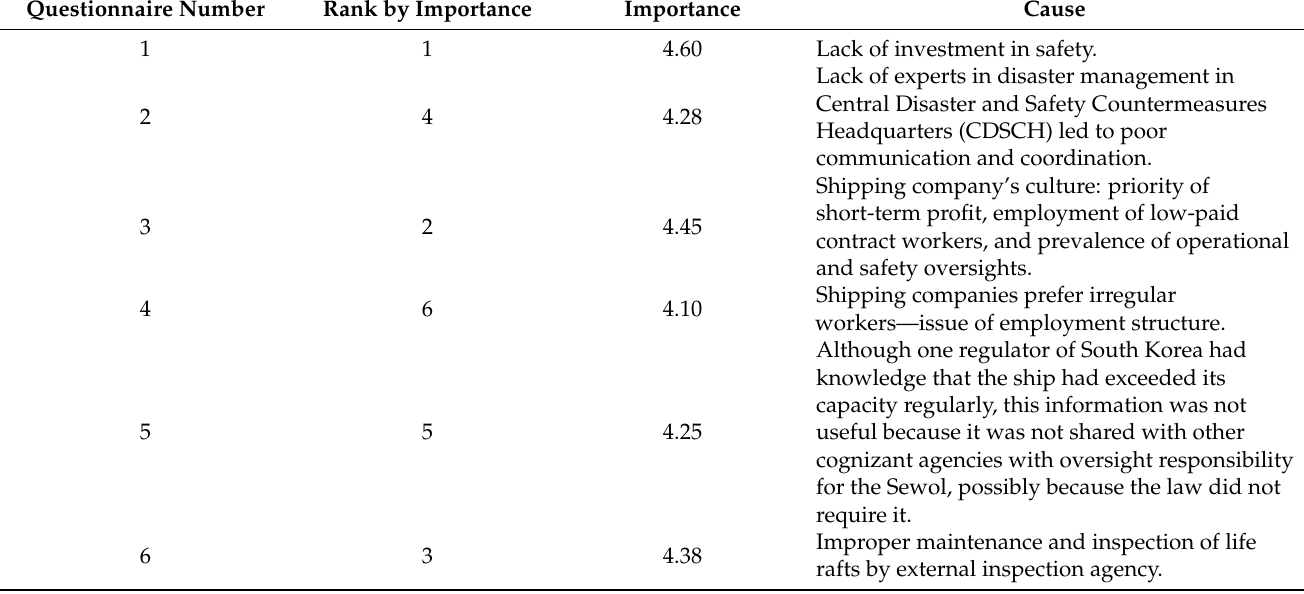
Table 8. Causes of the accident that were not addressed after the Sewol ferry accident. Questionnaire